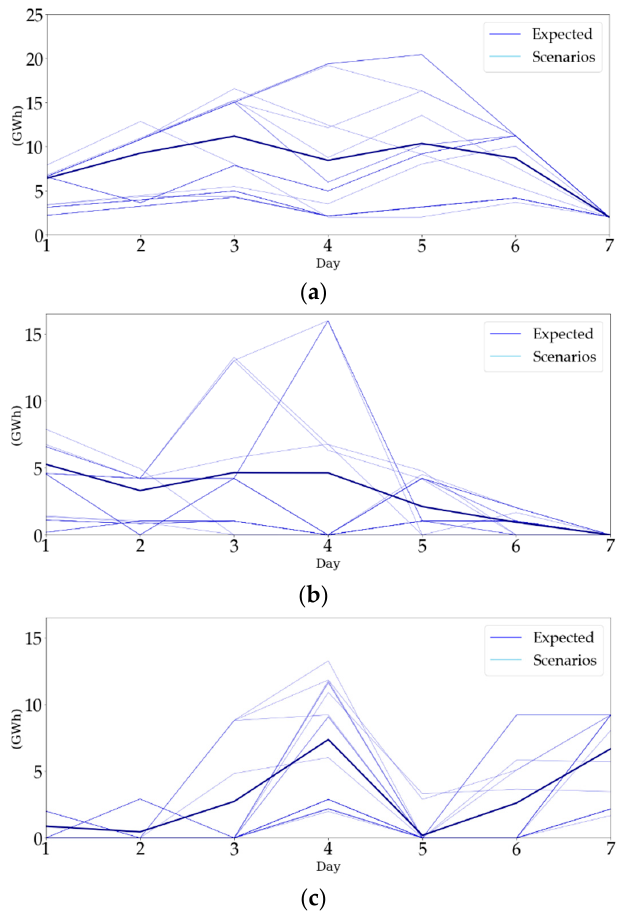
Figure 17. Storage operation per scenario. ( a ) Energy stored; ( b ) energy injected, and ( c ) energy withdrawn.